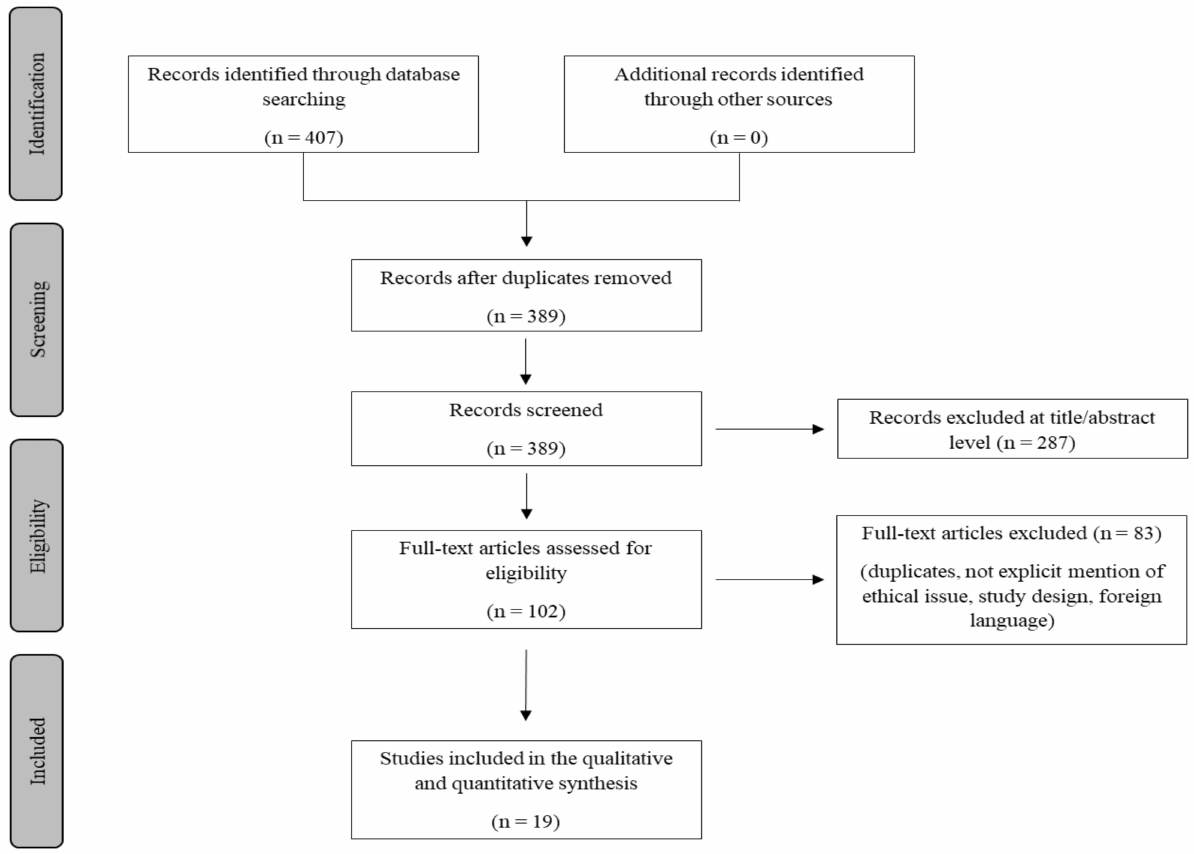
Figure 1. Methodology search strategy: we identified 389 articles after removing duplicates, the screening based on their abstracts left 102 studies, and after a careful evaluation based on the aims of this review 19 research articles were